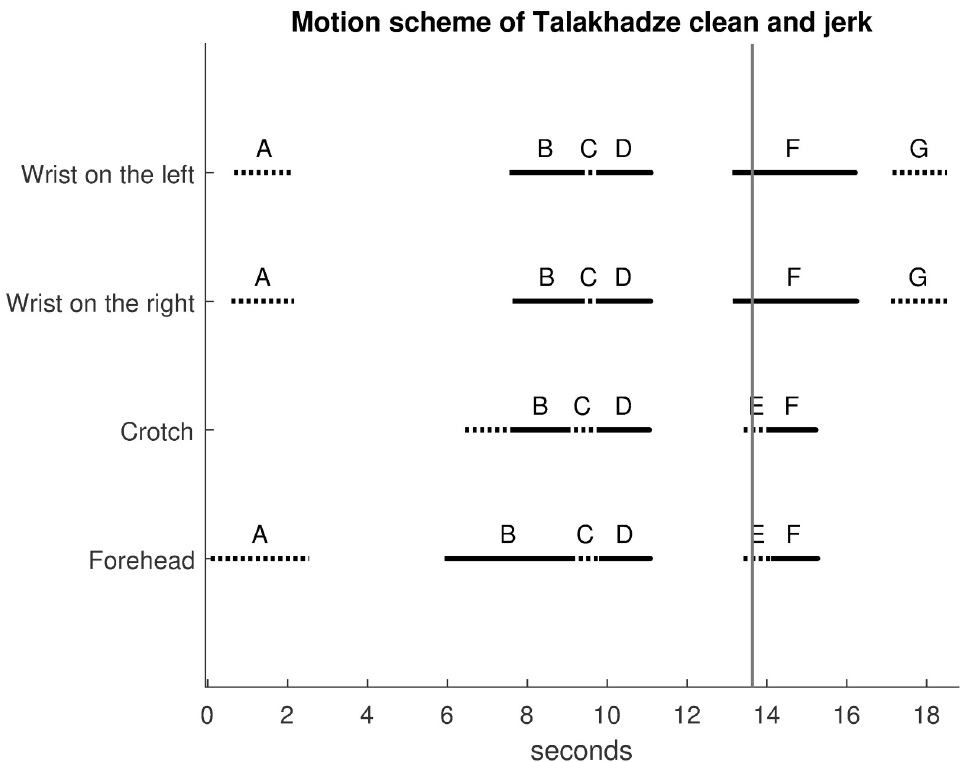
Fig 33. Motion scheme of Talakhadze clean and jerk. The motion scheme for Talakhadze describes precise timing of movements. The continuous segments correspond to upward movements while the dotted segments correspond to downward movements. The black vertical line at 13.64 seconds indicates when the barbell passes over the forehead.